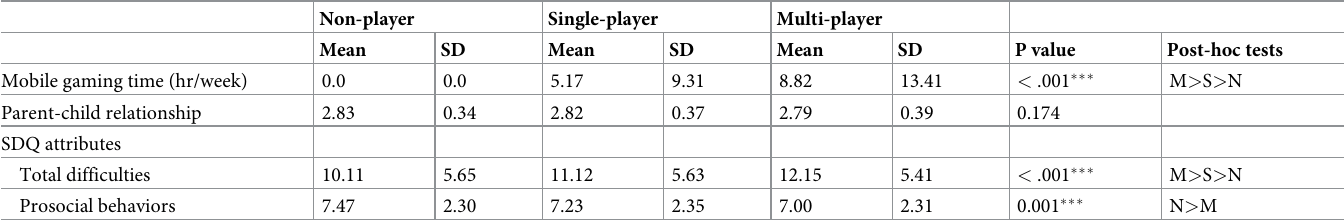
Table 4. Children’s mobile gaming time and SDQ by gaming preferences.